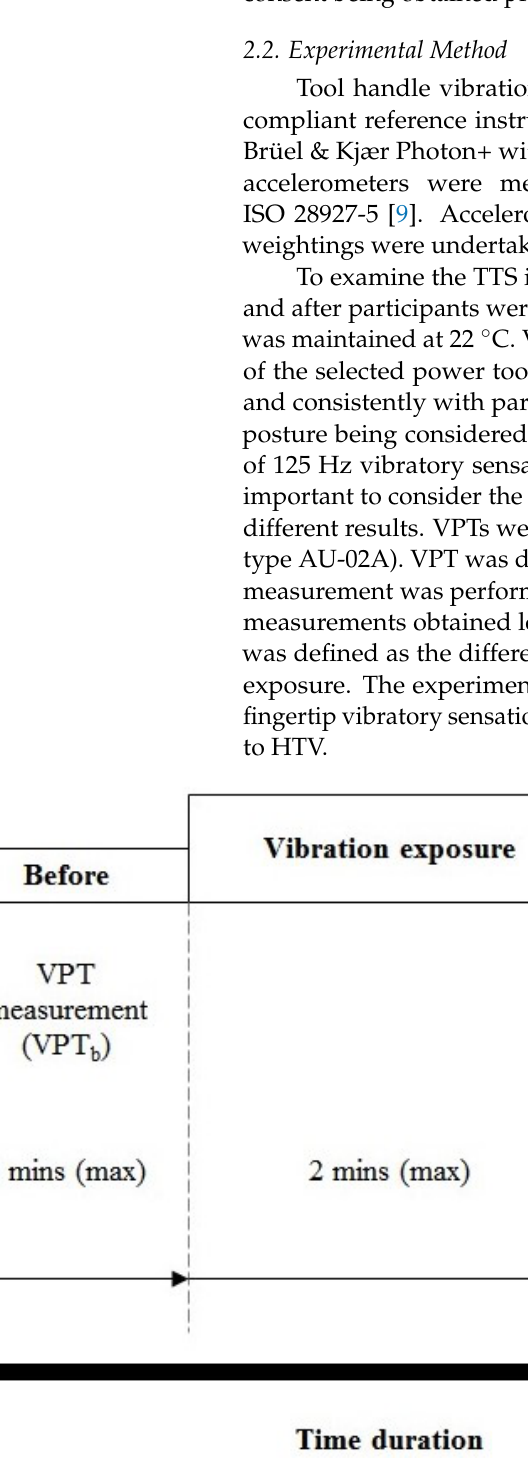
Figure 1. Experimental procedure for VPT measurement before and after tool vibration exposure. TTS results were manually recorded at the test bench in close proximity to the exper- imental working area. Tool handle data were recorded using the Svantek SV106 device and the Photon+ software interface connected to a laptop computer. Post-processing of acquired data was undertaken with Matlab 2019a and Python